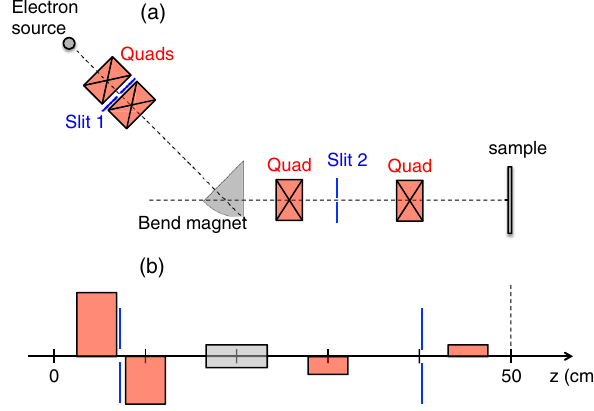
FIG. 3. (a) Schematic representation of the static compression beam line. Note the presence of two slits which are used to trim the electron distribution. (b) Conventional representation of the beam line showing the distance between magnetic elements: one-half of each quadrupole magnet is depicted, above the beam center line for a converging lens (in the x plane) and below the center line for a diverging lens. The sample plane lies at z ¼ 50